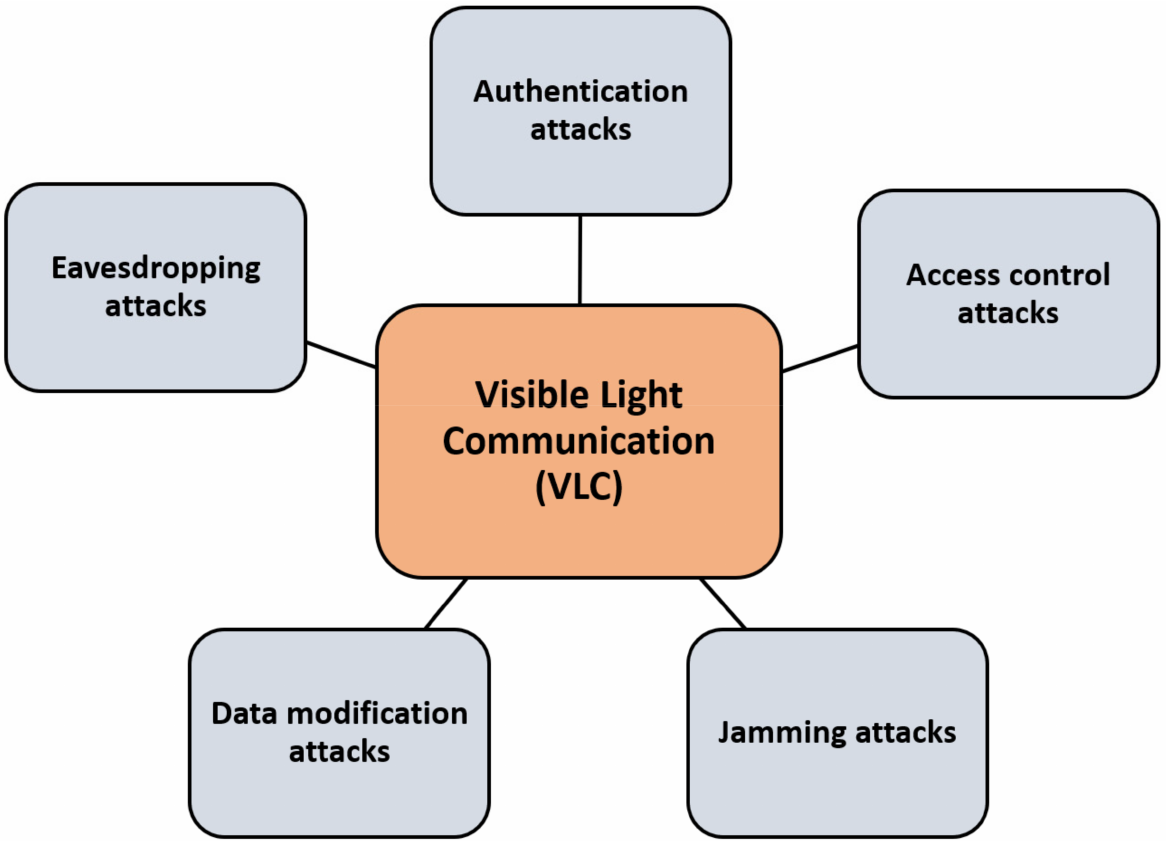
Figure 4. The 6G visible light communication technology attacks and